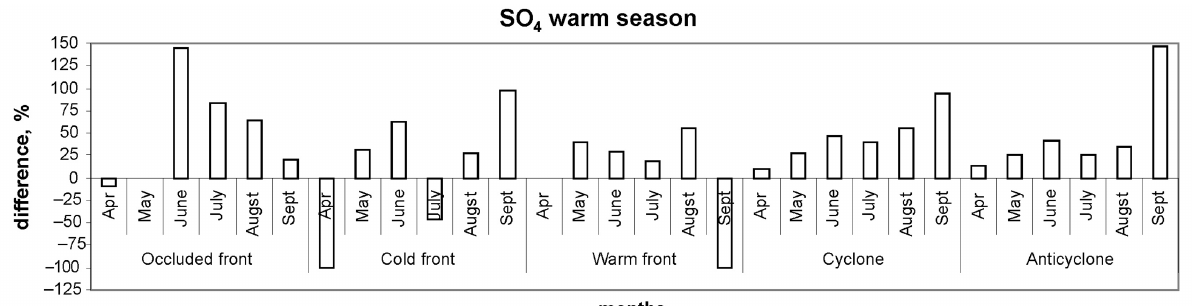
Fig 8. Difference between SO 4 three-year monthly average and average concentration during cold season at Preila background station